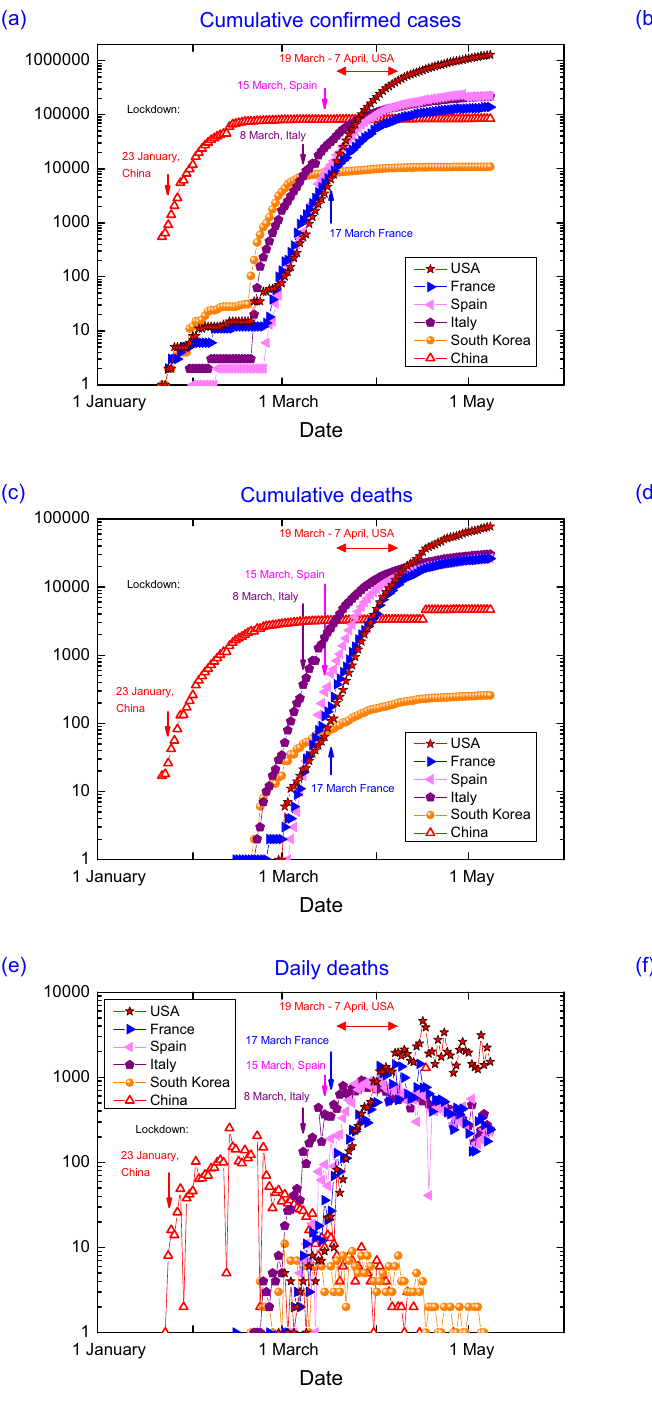
Figure 1. Focus on six countries: China, South Korea, Italy, Spain, France (mainland) and the USA [27 – 31]. Plots of cumulative con fi rmed cases (a) versus date and (b) versus “ shifted ” time, of cumulative deaths (c) versus date and (d) versus “ shifted ” time, and of daily deaths (e) versus date and (f) versus “ shifted ”